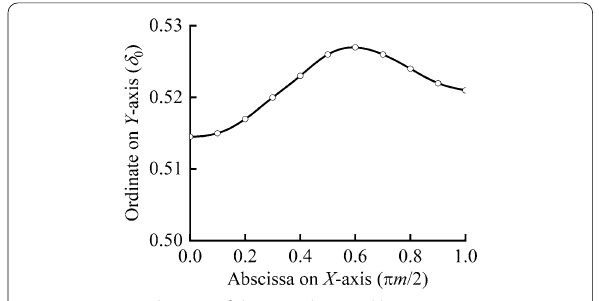
Figure 11 Distribution of the actual neutral